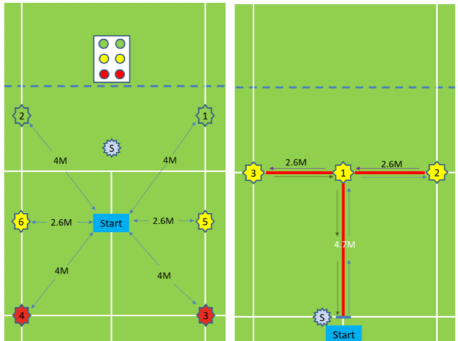
Figure 1. Six-point and T-shaped footwork drills and measurement